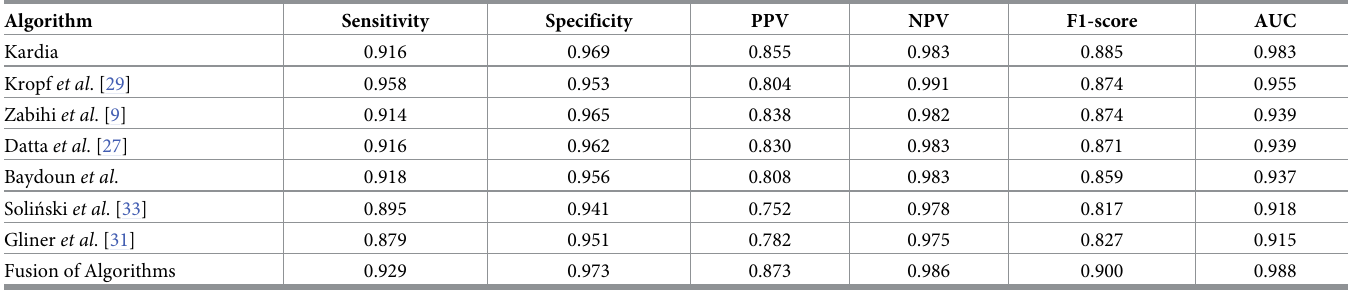
Table 2. The classification results of the selected algorithms as well as the fusion algorithm on the test dataset.